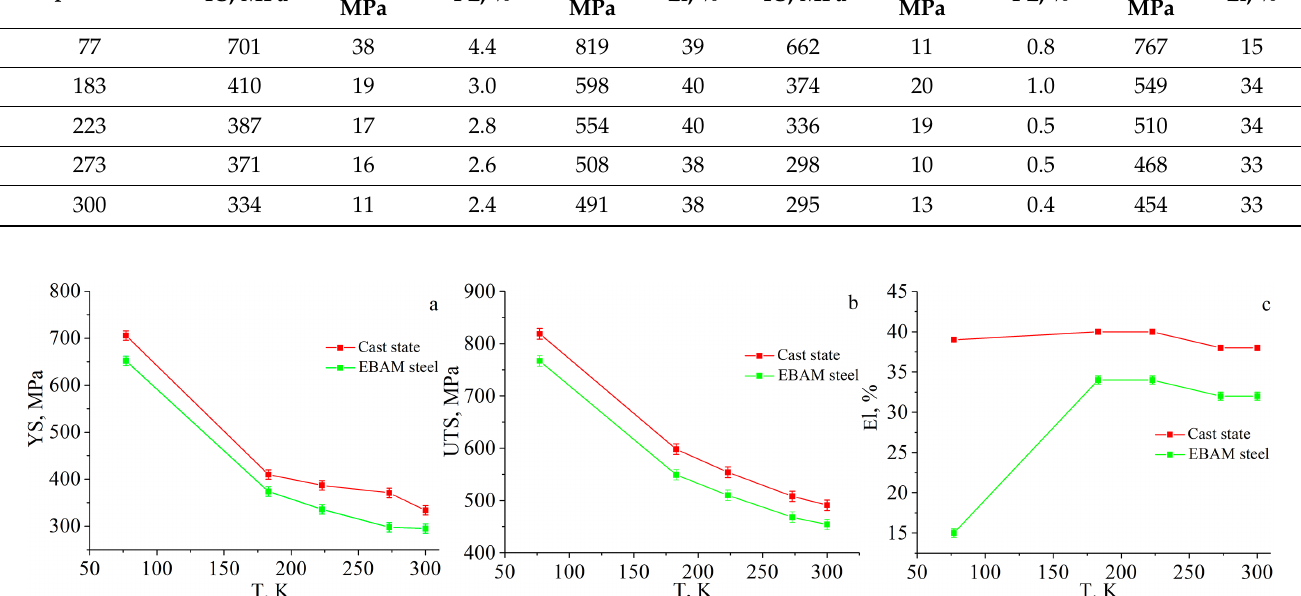
Figure 5. Temperature dependences of the mechanical properties of the low-carbon steel in the cast state and after the EBAM process: ( a ) the yield strength (YS), ( b ) the ultimate tensile strength (UTS), and ( c ) the elongation to failure (El).